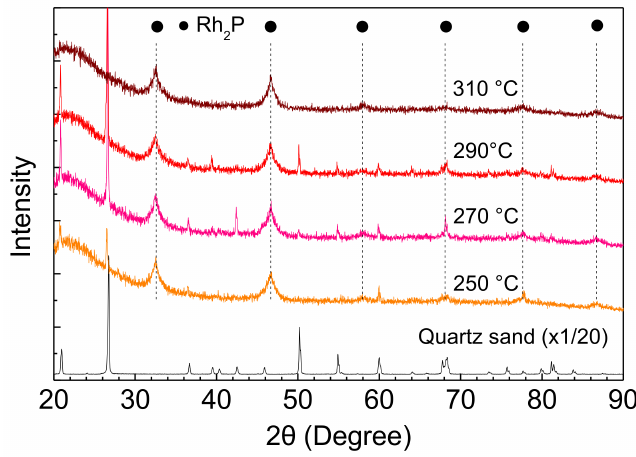
Figure 8. XRD patterns of Rh-P catalysts after the HDS of 4,6-DMDBT at different reaction